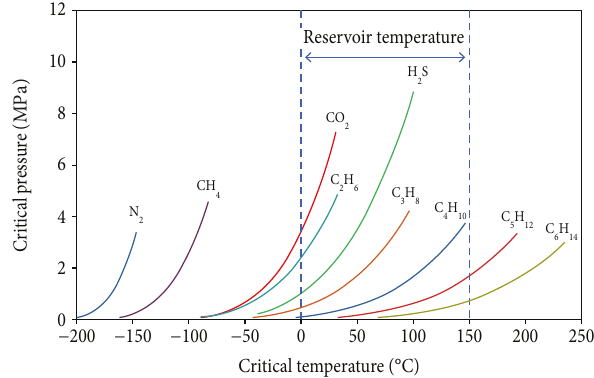
Figure 6: P-T phase diagram of elementary gas.